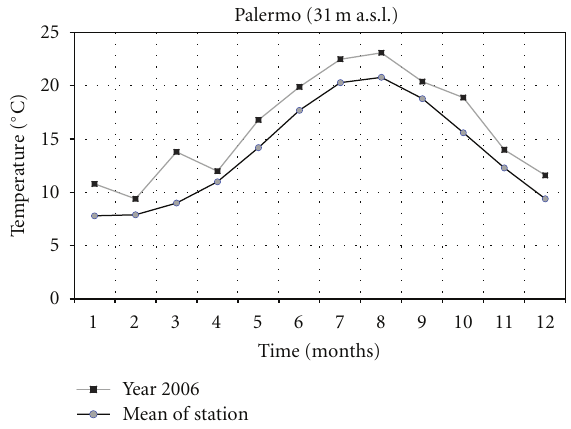
Figure 1: Daily minimum temperature trend in 2006 compared with the mean trend registered in the thermopluviometric station.